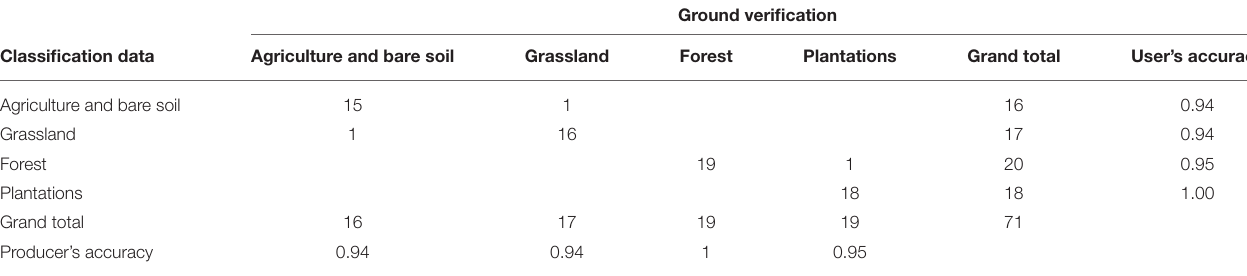
TABLE 2 | Raw tally confusion matrix of land cover and accuracies of the RapidEye (January 3rd 2015) classification.